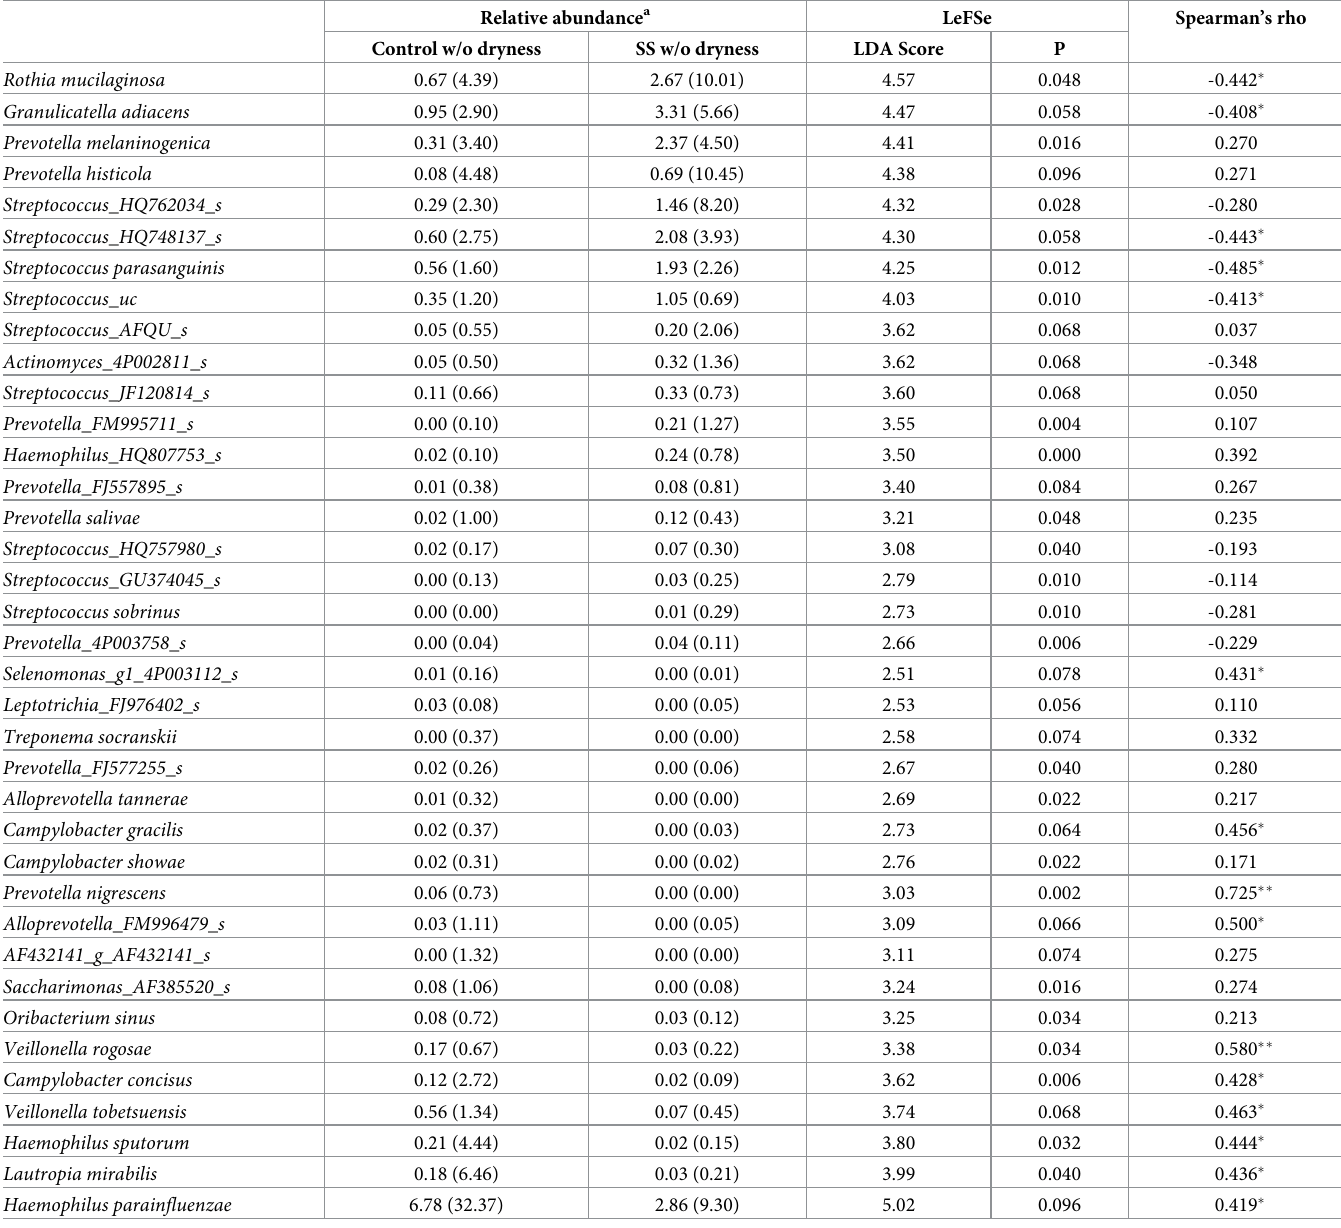
Table 3. Species associated with SS normalcy (n = 8) vs. control normalcy (n =